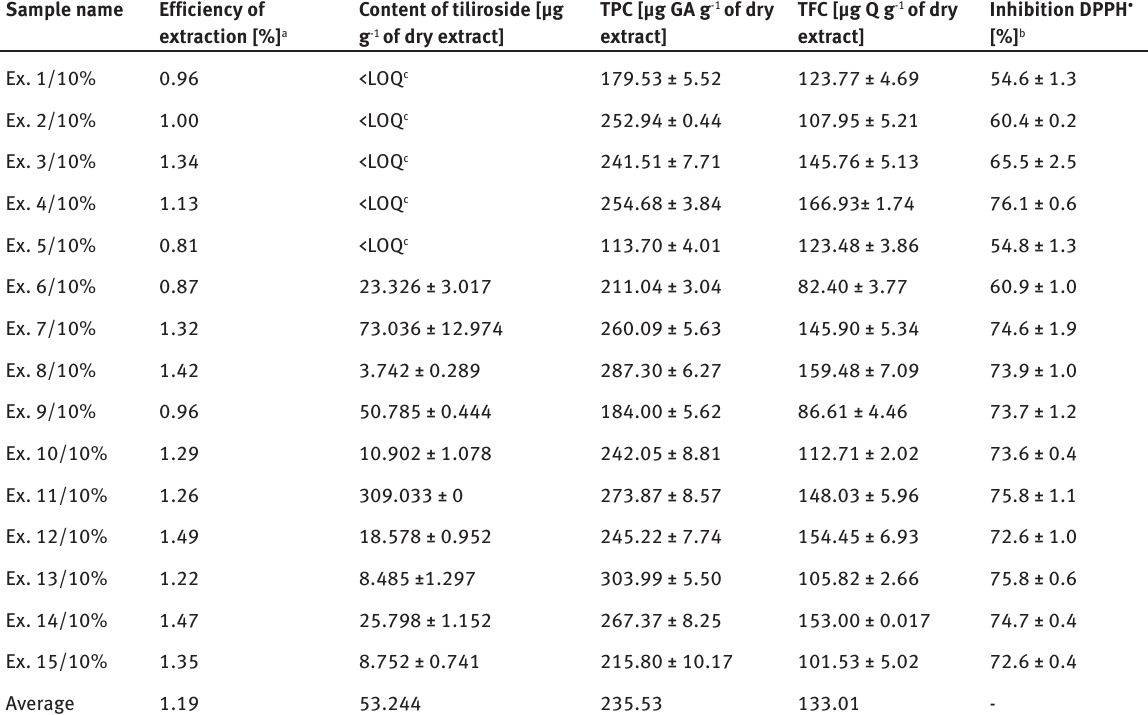
Table 6: Efficiency of extraction, content of tiliroside, TPC, TFC and antioxidant activity of SC-CO Tilia L. flowers.